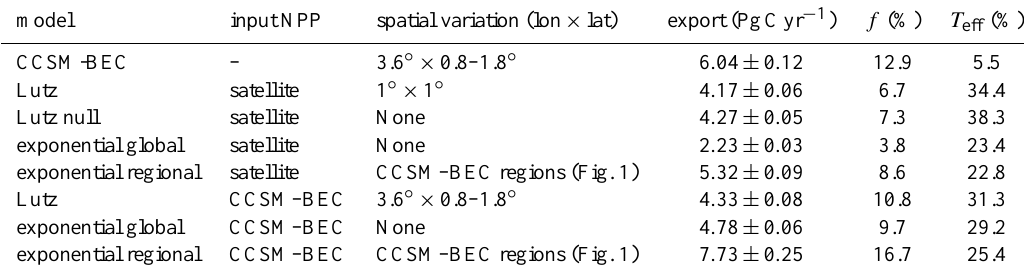
Table 6. Global annual POC export and area-weighted global mean export ratios (f = F z 0 × 100 ) for the eight POC flux models shown in Fig. 3. The 95% confidence interval for the global export estimates from the F 2000m /F z 0 POC POC different models were computed using the bootstrap method with 10000 samples drawn randomly with